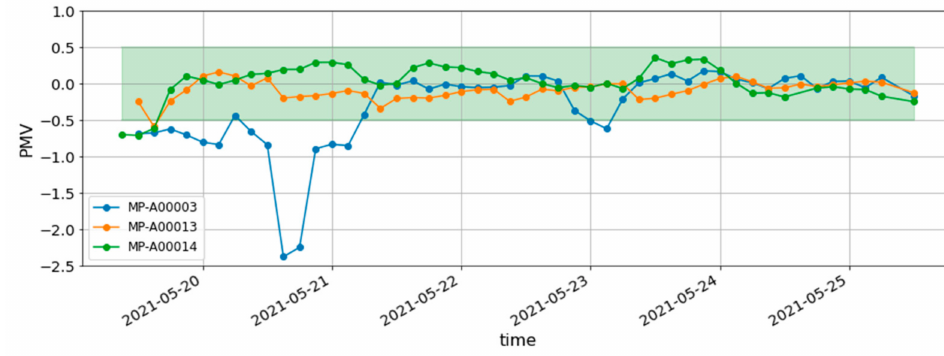
Figure 18. PMV values for the three platforms.